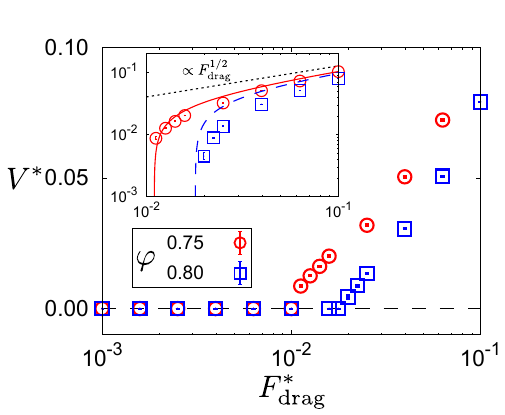
Figure 2. Relation between the drag force F drag and the steady speed V for ϕ = 0 . 75 (open circles) and 0 . 80 (open squares) when we fix D = 10 d , where we have introduced F ∗ √ k n / m ). The inset shows the log-log plot for the and V ∗ ≡ V / ( d same data. The solid (dashed) line in the inset represents Eq. (2) with Eq. (3) for ϕ = 0 . 75 (0 . 80). Here, the dotted line is a guide line for V ∝ F 1 / 2 . drag